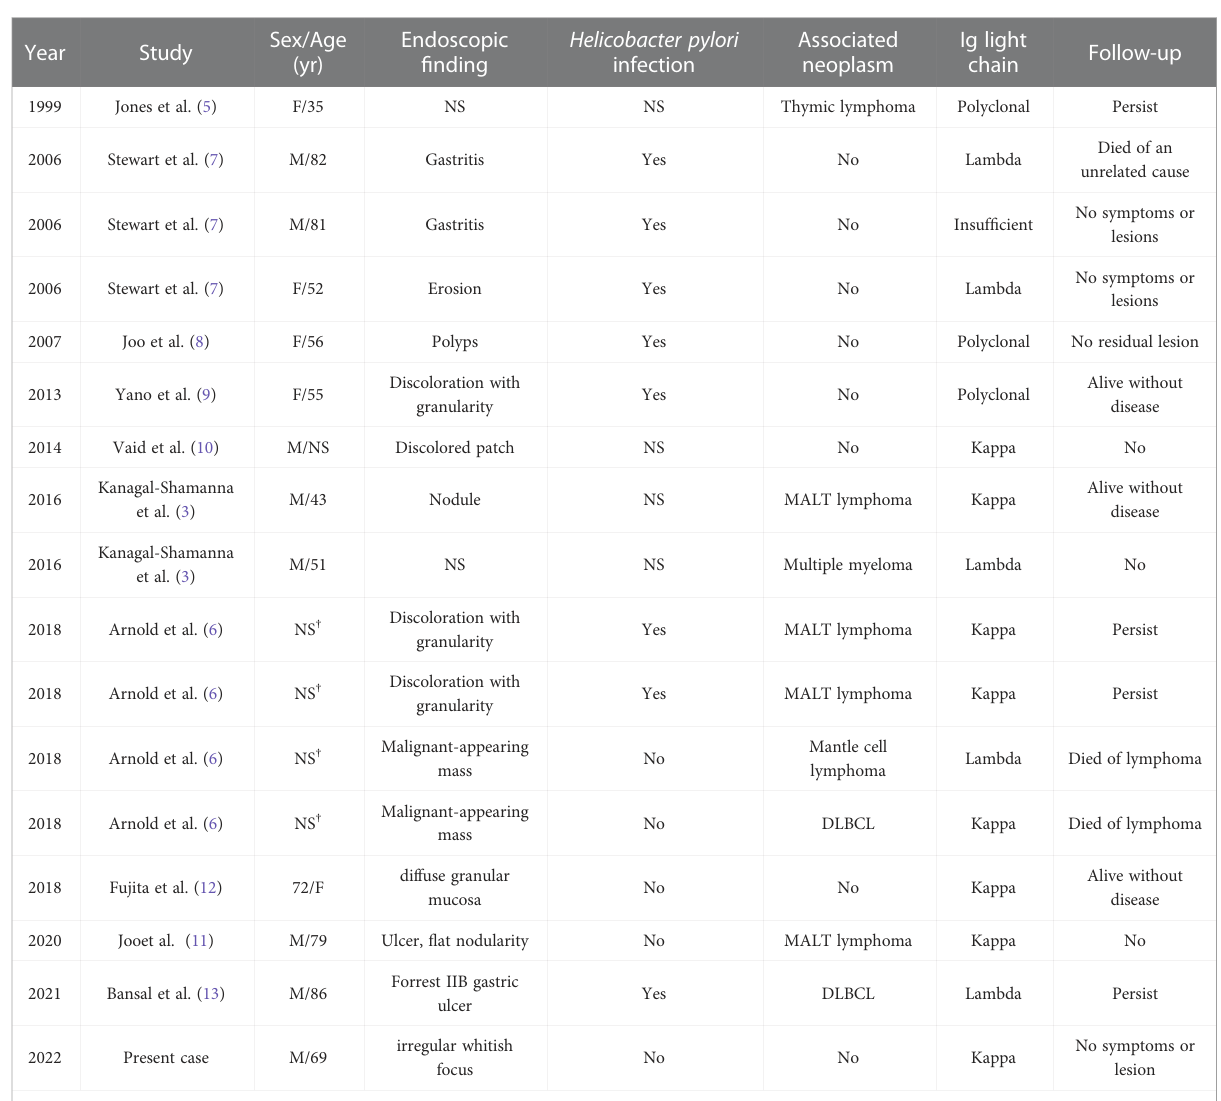
TABLE 1 Clinical and pathological fi ndings of previously published cases of gastric crystal-storing histiocytosis in English